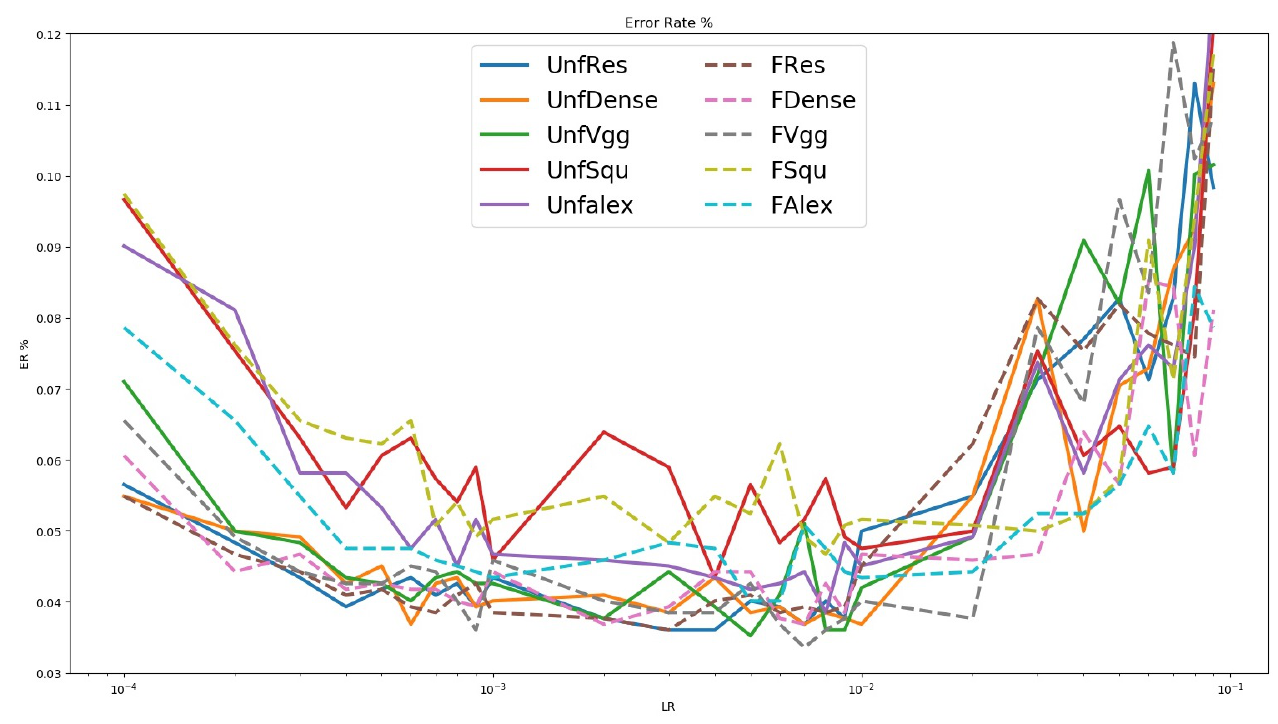
Figure 7. Error Rate Results for tree health classification for all learning rates and DL architectures. The most suitable results were obtained by Vgg, with the highest ER value of 0.03357% for FVgg and learning Rate (LR) = 0.007 (Figure 7). The same network reached